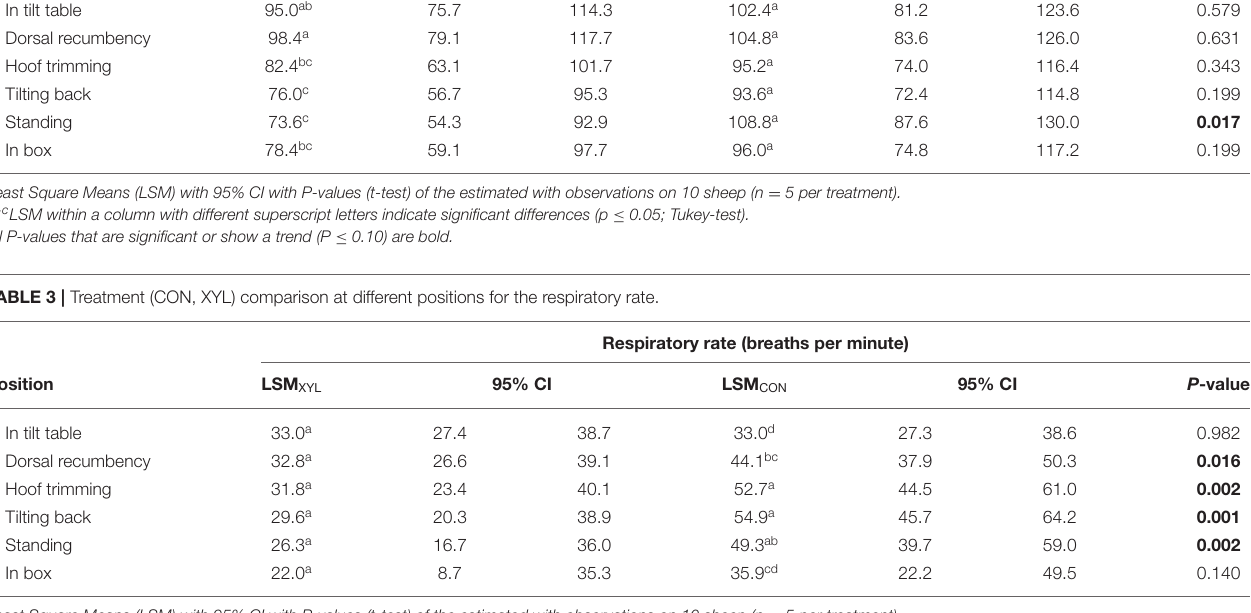
TABLE 2 | Treatment (CON, XYL) comparison at different positions for the heart rate. Position